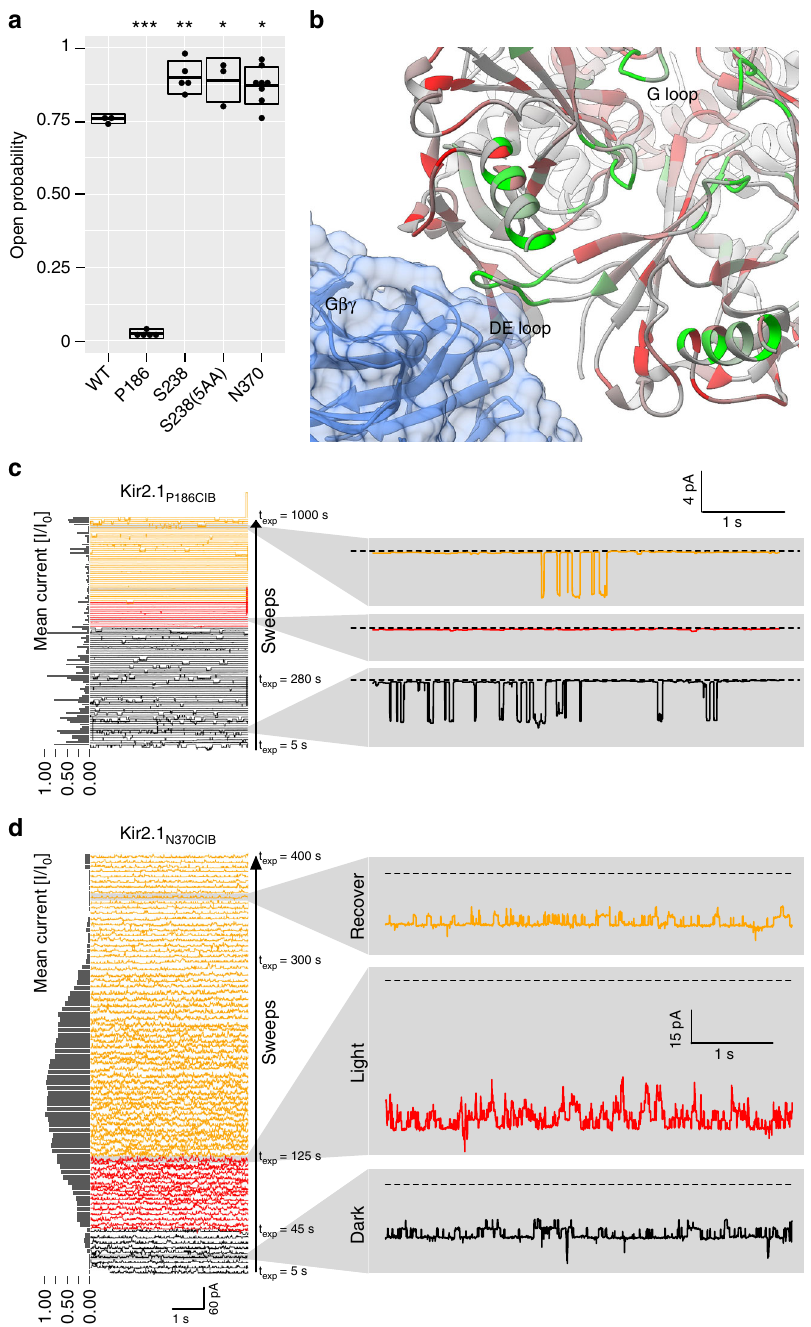
Fig. 7 Electrophysiology of light-switched Kir2.1 variants. a Open probability determined by on-cell patch-clamp electrophysiology for WT Kir2.1 or the indicated insertion mutant. Boxes indicate standard deviation, thick crossbar indicates mean, and dots indicate individual measurements ( n = 3 – 12). Signi fi cance is tested by Dunnett ’ s test for multiple comparisons with wild-type as control and post hoc multiple comparison adjustment. Signi fi cance levels: *** P < 0.001; ** P < 0.01; * P < 0.05; all others not signi fi cant. b PDZ domain insertion permissibility mapped increasing from red to green onto the crystal structure of GIRK2 (Kir3.2) in complex G βγ (PDB 4 KFM). Many highly permissive sites in Kir2.1 are homologous to those that interact with G βγ in GIRK2. c , d Representative examples of on-cell patch-clamp recordings of indicated insertion variant (P186CIB top, N370CIB bottom). Consecutive 5-s sweeps that spread out vertically are shown, bottom (beginning of the experiment) to top (end of the experiment). Black indicates sweeps before illumination, red during illumination, and yellow after illumination. Holding voltage is − 100 mV (P186CIB) and − 80 mV (N370CIB). Channels open inward (negative current). Normalized mean current for each sweep is shown on the left as a bar graph. Magni fi ed individual sweeps before (black), during (red), and after illumination (yellow) are shown on the right. While Kir2.1 P186CIB responds to illumination with further decreasing the already small open probability, Kir2.1N370CIB is activated with